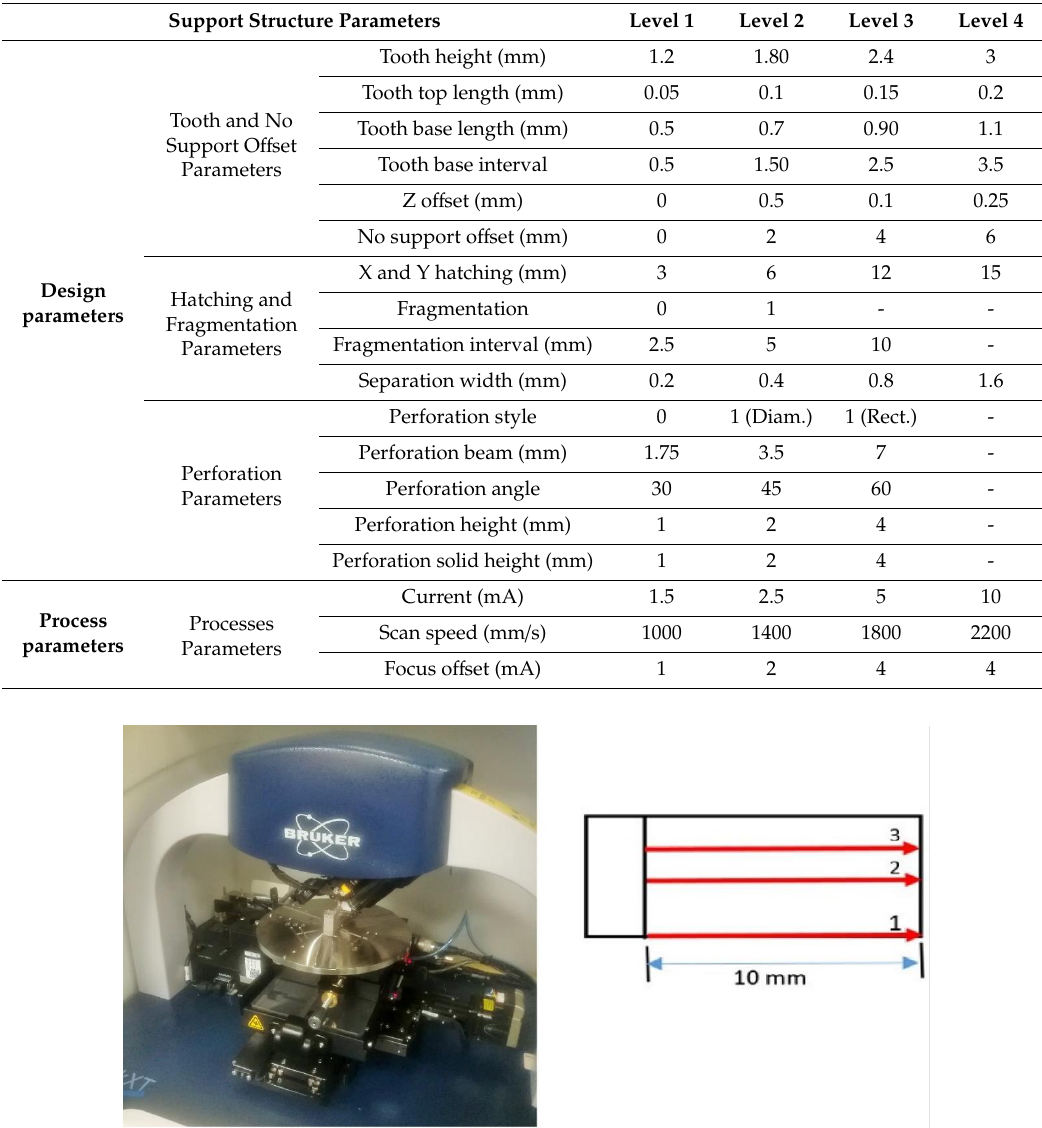
Figure 2. Fabricated specimens: ( a ) specimens on sintered powder; ( b ) specimens after sand blasting.